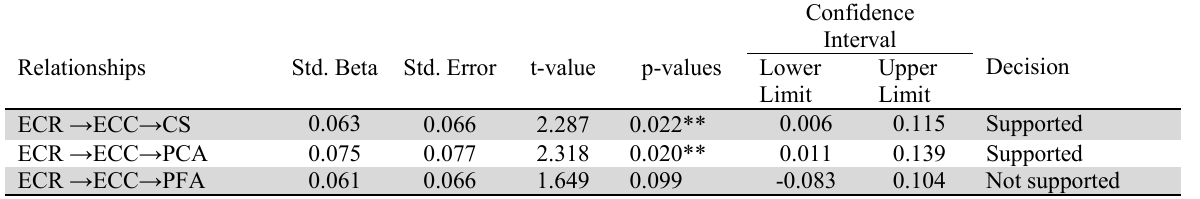
Confidence Interval Decision Lower Upper Limit Limit